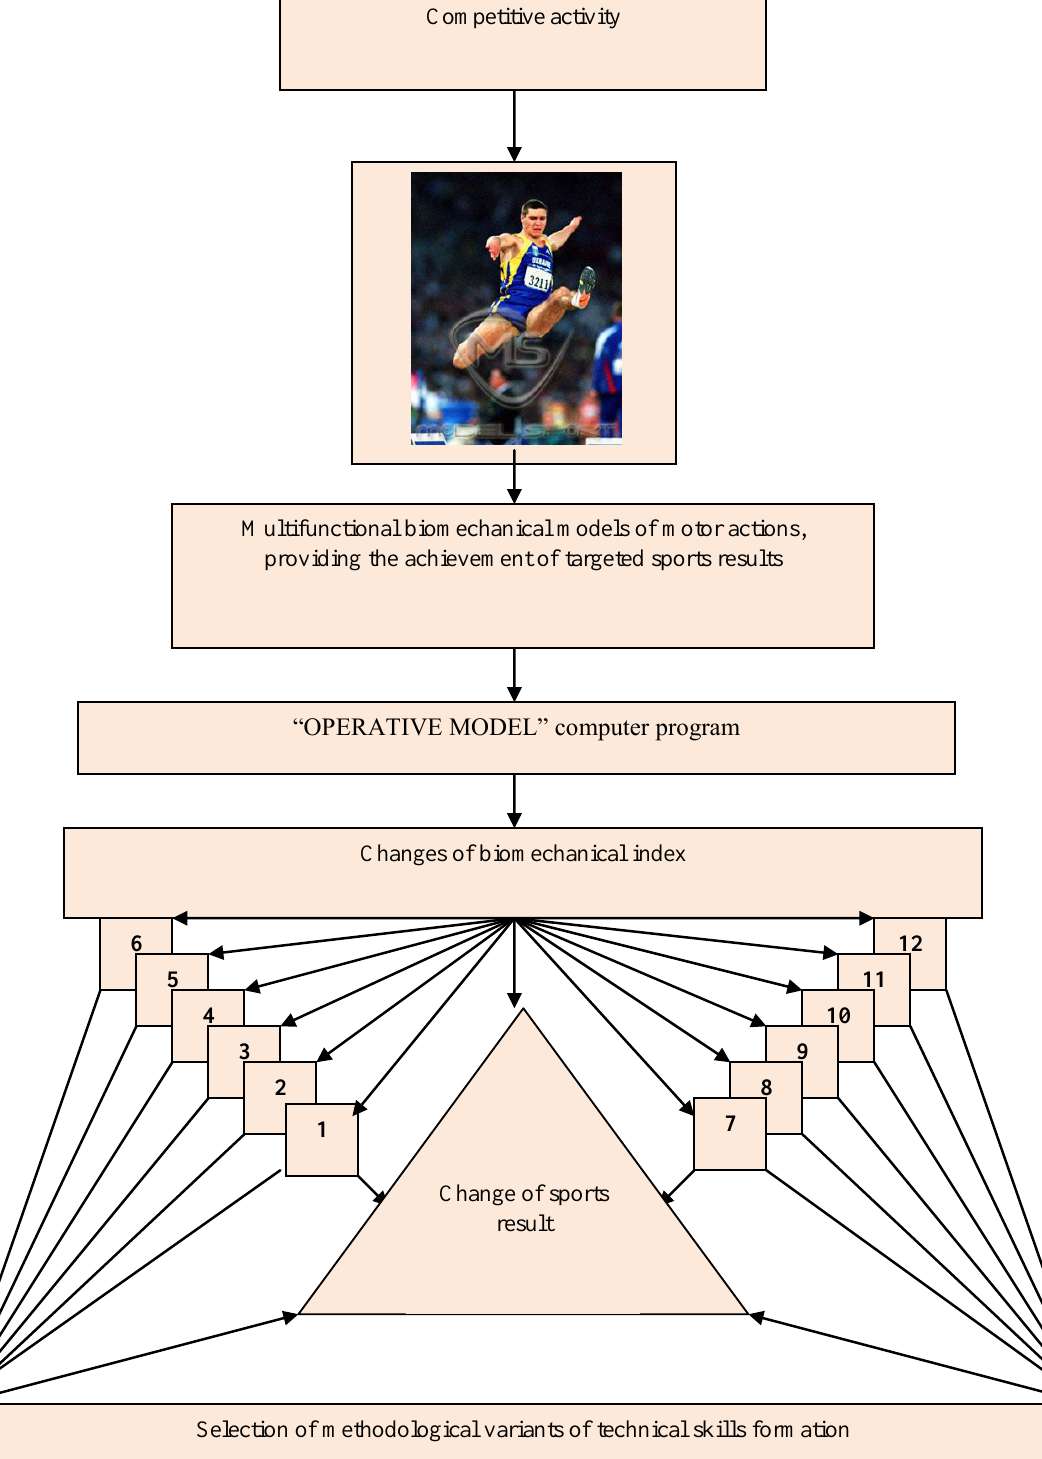
Fig. 2. Diagram of the technology of operative biomechanical modelling of track and field competitive jumps